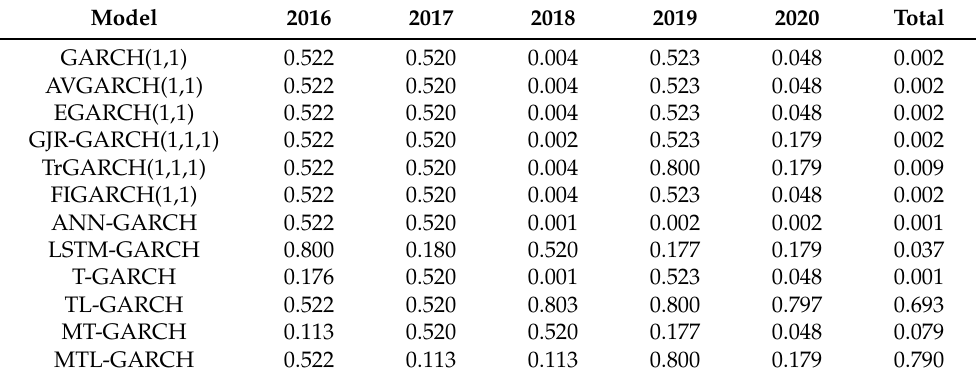
Table 5. Christoffersen test ( p -values) by volatility model and year.